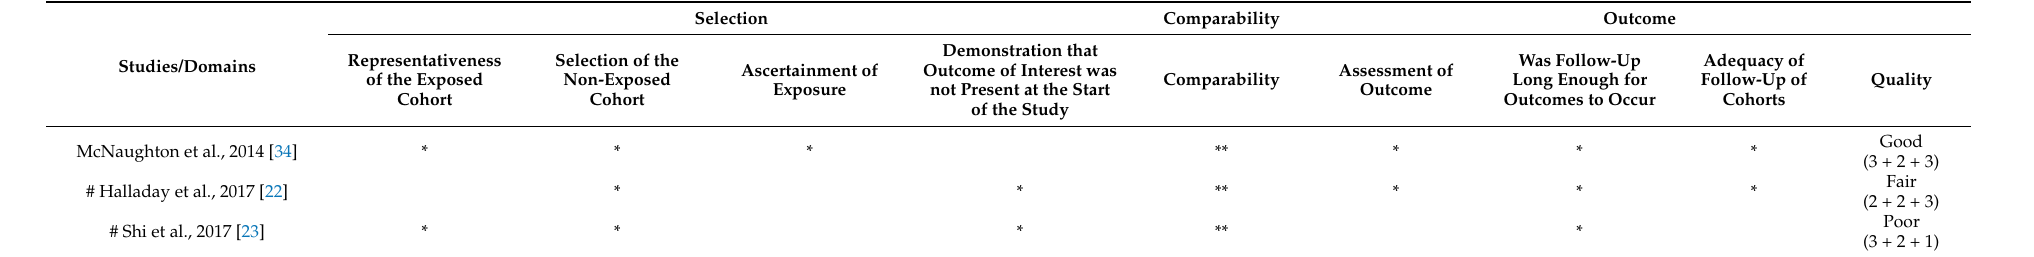
Table 5. Summary of quality assessment of the included studies using Newcastle-Ottawa Quality Assessment Scale (Cohort Studies).